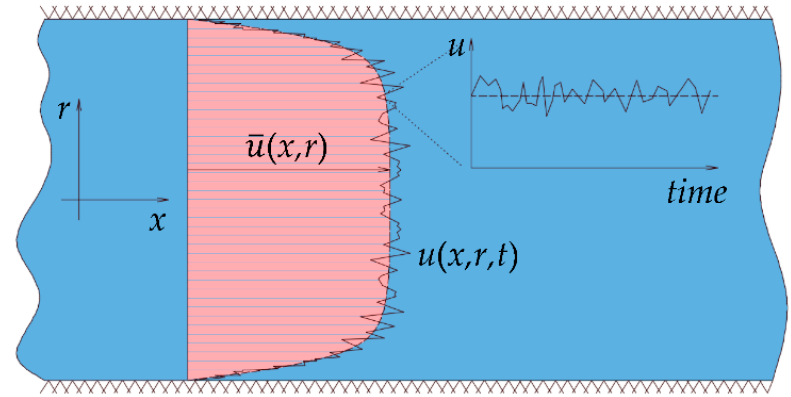
Figure 1. Schematic of the averaging volume along with the vectors x and r .